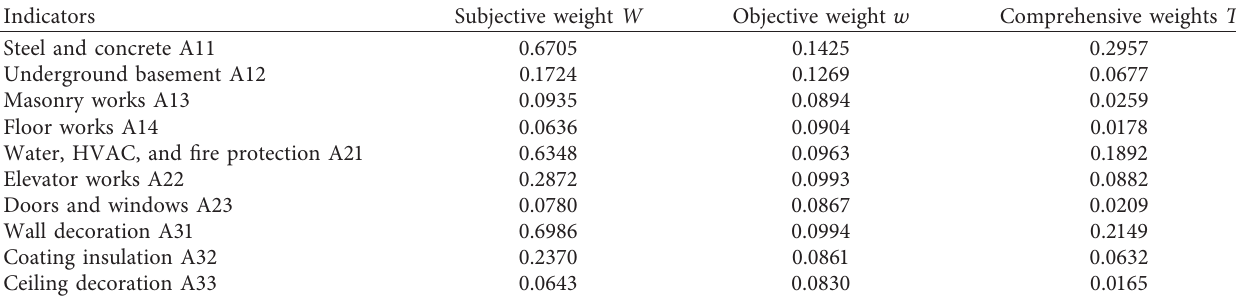
Table 9: Comprehensive weight calculation results.